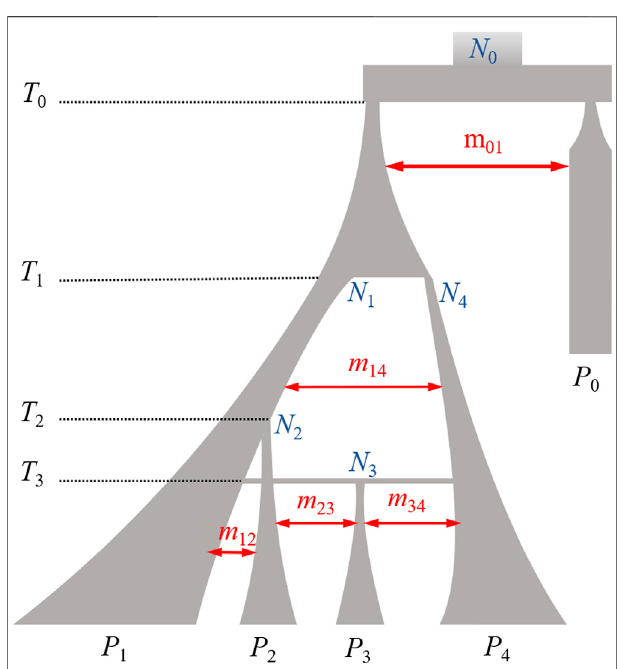
FIGURE 1 | Illustration of the simulation demographic model. Branch width corresponding to population size and time fl owing from the top to the bottom. The width of the double arrows is proportional to the migration intensity. T i , number of generations back to the population history event; N j , effective population size of P j population; m xy , migration rate between P x and P y . Model details are provided in Table 1 and Supplementary Text S1 .